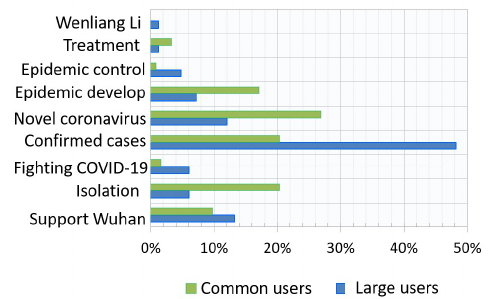
Figure 3. Hot event (topics people were talking about) distributions among common users and large users during